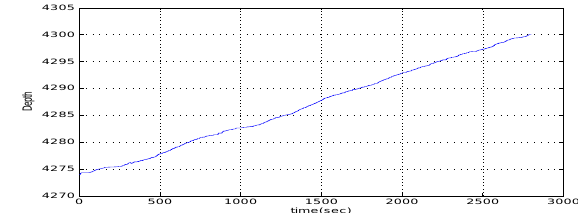
Figure 1: Measured depth used in the case study